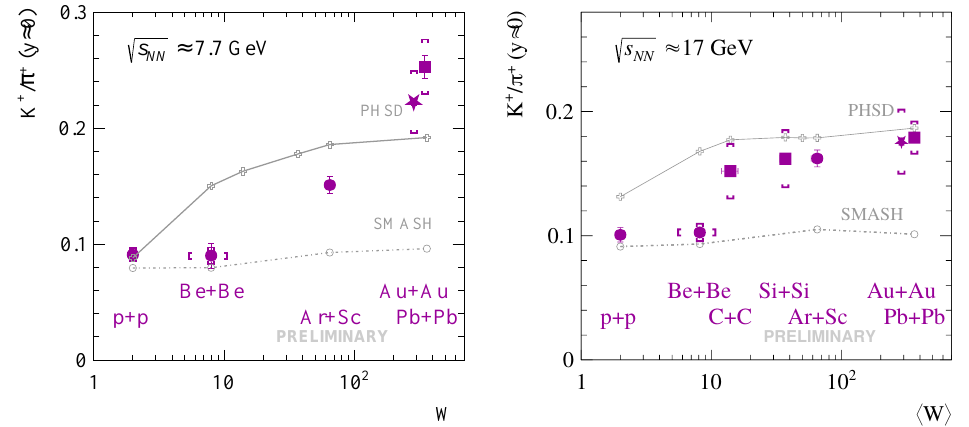
√ √ s NN ≈ 7.7 GeV ( left ) and s NN ≈ 17 GeV